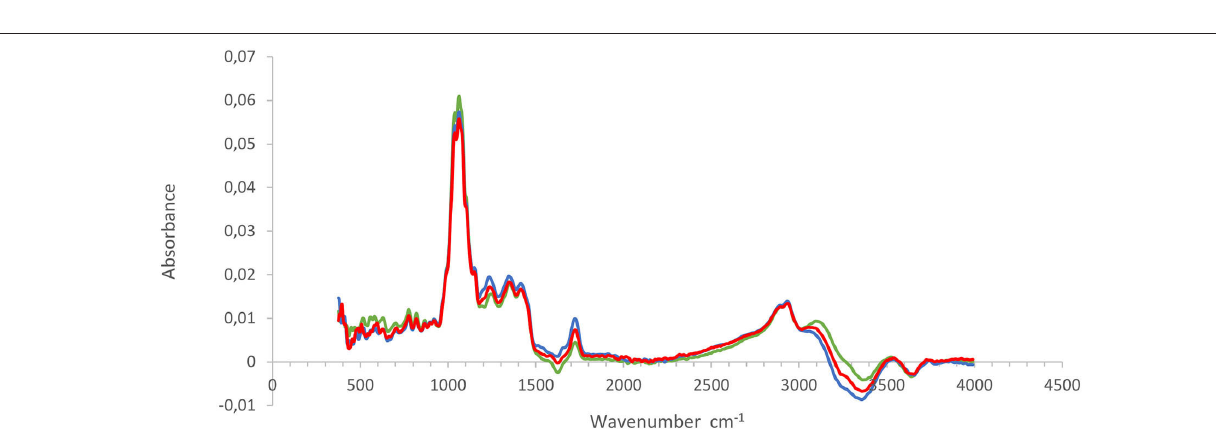
FIGURE 2 | Description of the FT-IR spectral characteristics from pomegranate juice extracted by using three different methods. Green, commercial hand press juicer (CH); blue, juice blender (JB) (crushing the arils with the seeds); and red, juice extractor (JE) (extract juice from arils without crushing the